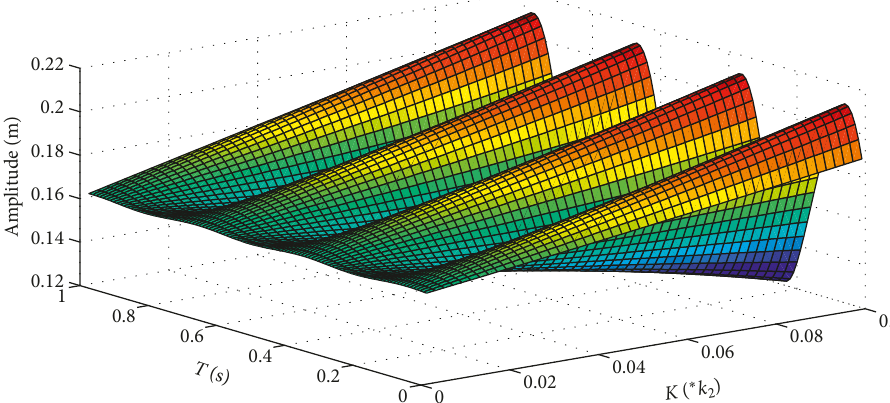
Figure 10: Variation of vibration amplitude of m 2 with time-delay parameter T and strength parameter K